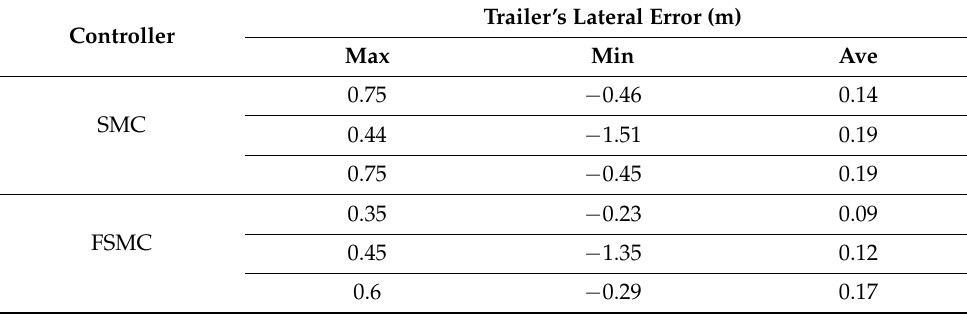
Table 4. Statistics of trailer path tracking error after going